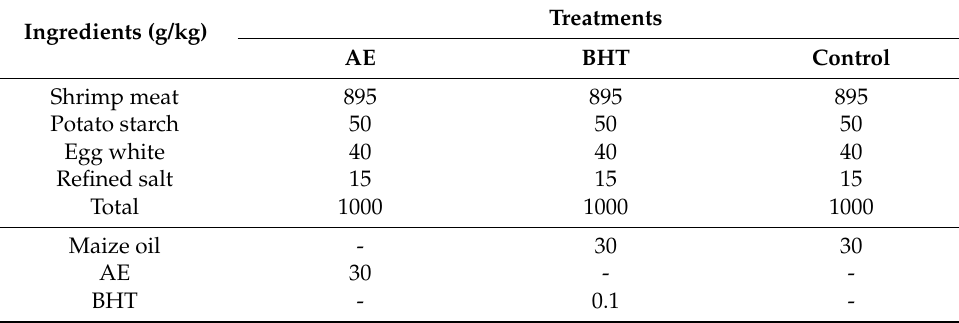
Table 1. Formulation of shrimp surimi products with different